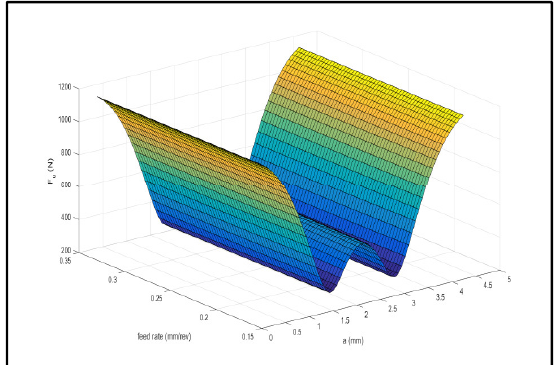
response against & "